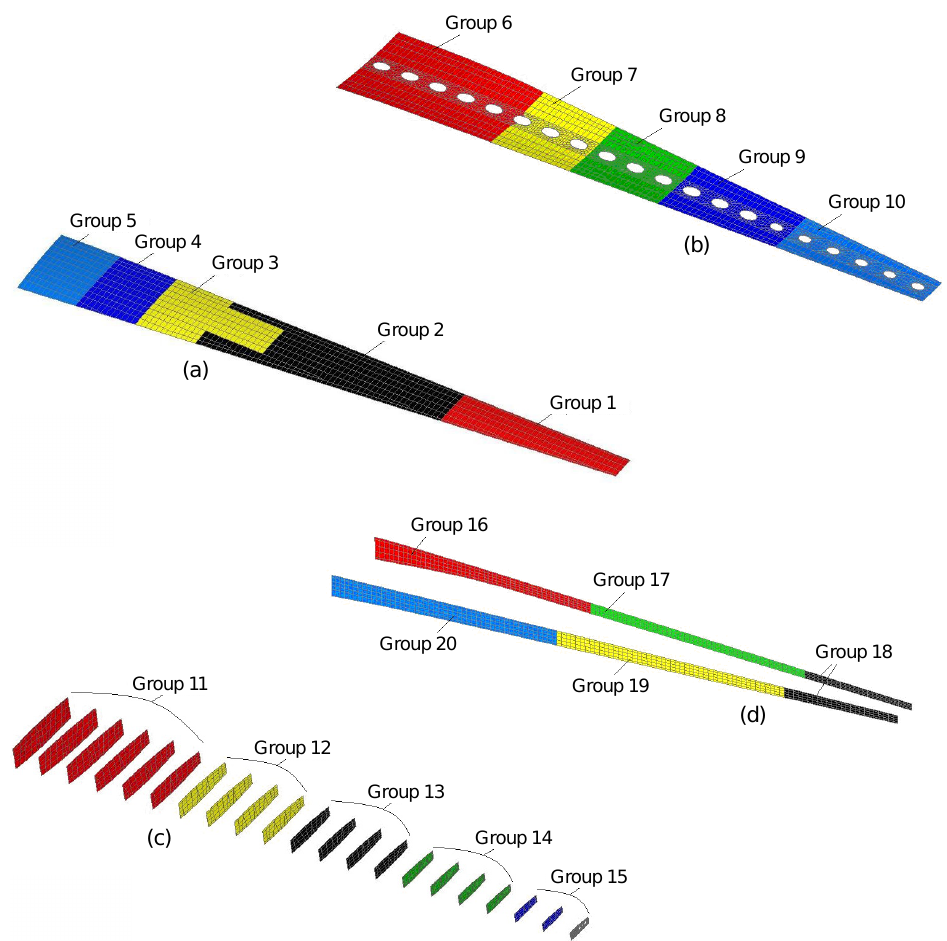
Figure 5. Test Problem 1 (wing box): groups of shell finite elements defined for design variable configuration C 3 of the wing box. The elements in each group share the same design variable, i.e., they have the same thickness. The 20 design variables of C 3 are allocated to the wing box’s: ( a ) upper surface (Groups 1–5), ( b ) lower surface (Groups 6–10), ( c ) rib surfaces (Groups 11–15), and ( d ) side surfaces (Groups 16–20).